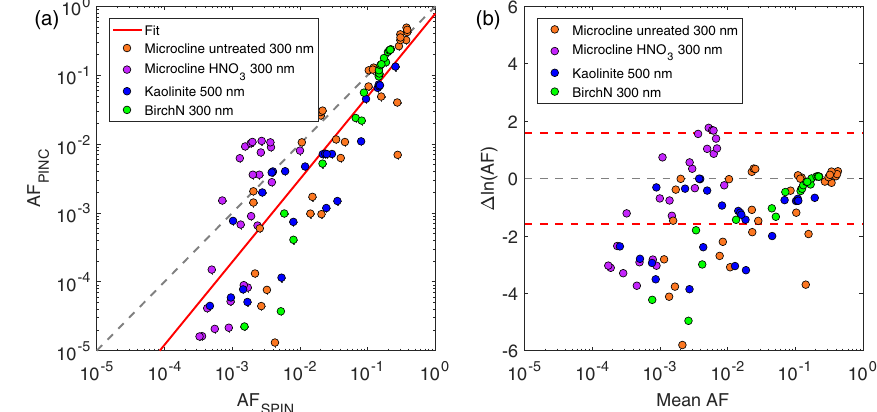
Figure 6. (a) Correlation of the AF measured with PINC and SPIN differentiated for aerosol types. Data are binned in ± 2% in RH w to obtain the correlation. (b) Differences in the AF between PINC and SPIN as a function of their mean measured AF. The dashed red lines show the standard deviation (1 σ )